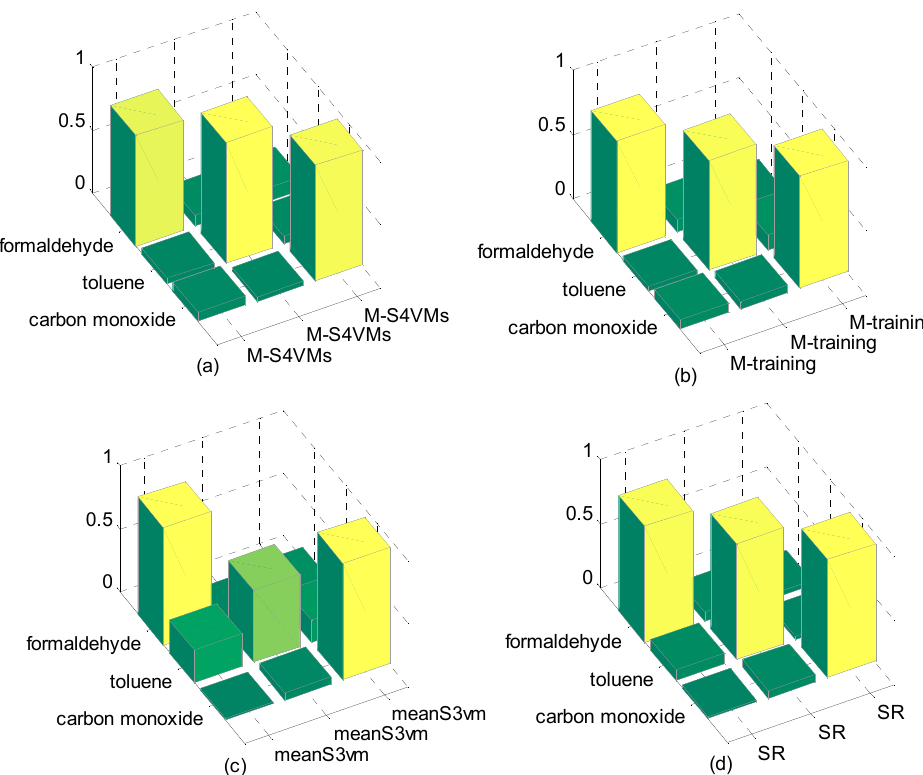
Figure 10. Accuracy rate of the four semi-supervised algorithms. These are the classification results based on three target gases with two normal semi-supervised algorithms which are M-S4VMs ( a ); M-training ( b ); meanS3vm ( c ); SR ( d ), respectively. It is clear that M-S4VMs has the ideal performance in classification. Although other algorithms also performs well in some specific gases classification, M-S4VMs still works better than them in terms of total three gases classification.